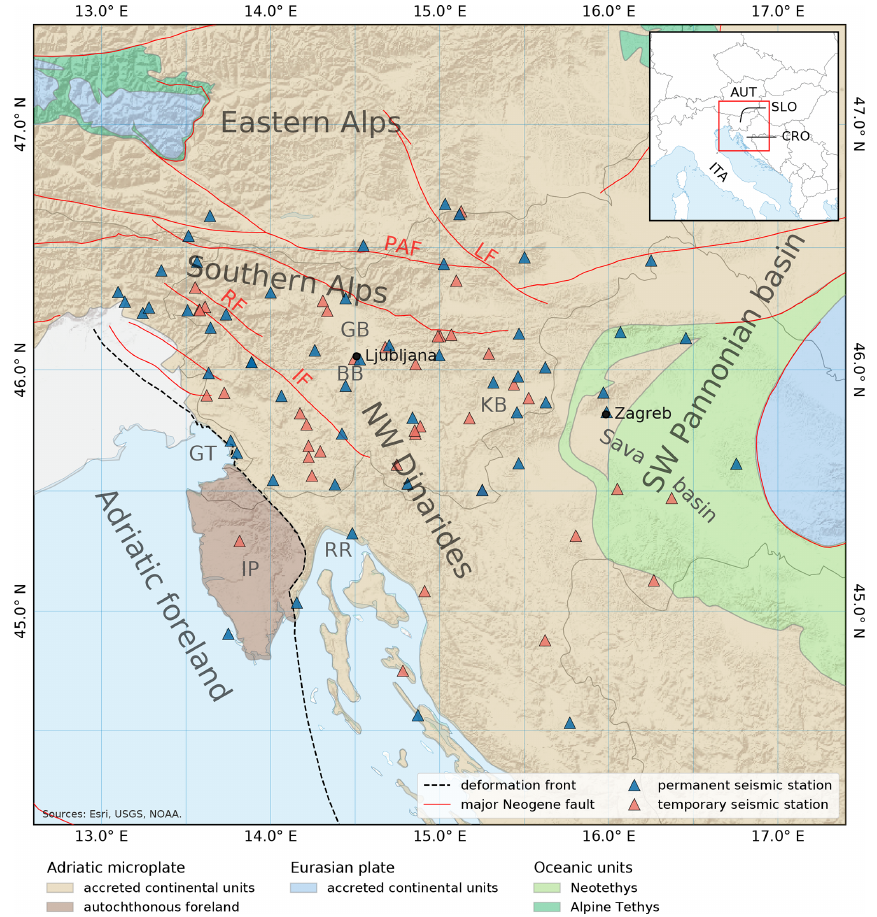
Figure 1. Map of the study area. Seismic stations used in this study are shown on top of the regional tectonic map and major Neogene faults (adapted from Schmid et al., 2008). The dashed black line represents the current main deformation front of the Dinarides. GT stands for Gulf of Trieste; IP stands for Istra peninsula; RR stands for Rijeka region; GB stands for Gorenjska basin; BB stands for Barje basin; KB stands for Krško basin; IF stands for Idrija fault; PAF stands for Periadriatic fault; RF stands for Ravne fault; LF stands for Labot fault; AUT stands for Austria; CRO stands for Croatia; ITA stands for Italy; SLO stands for Slovenia. A shaded relief is shown in the background (Esri, USGS,